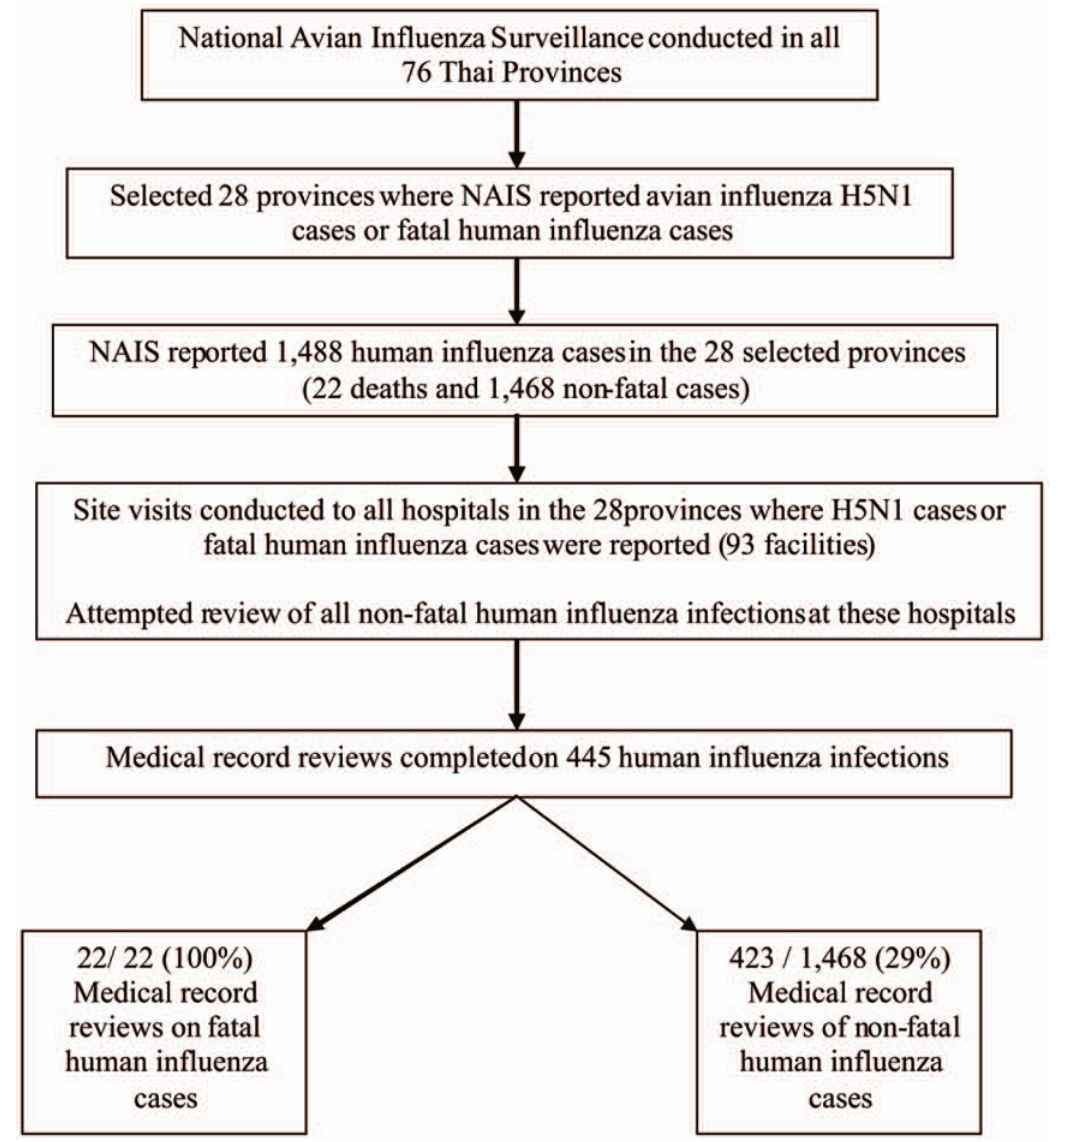
Figure 1. Sample selection process.